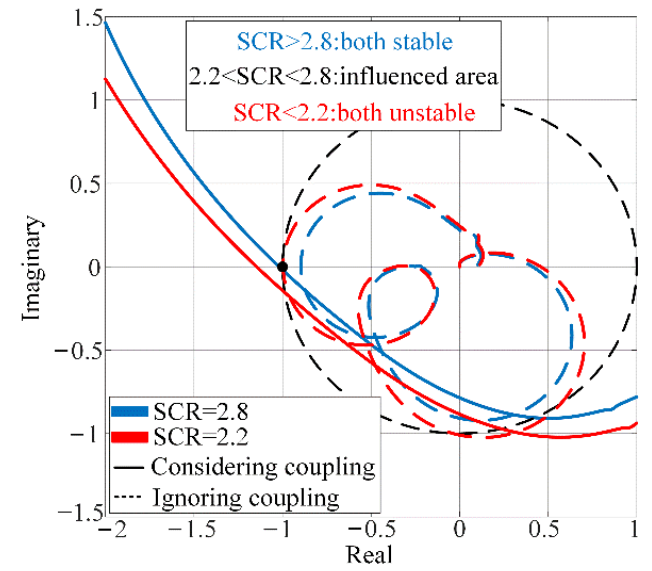
Figure 17. Nyquist plot of the impedance ratios Z g ( s ) Y MMC ( s ) with PLL dynamics. Figure 18 shows the time-domain simulation results of the MMC under a step change of the grid condition, where the PLL bandwidth is set as 40 Hz. It can be seen the system loses stability when SCR = 2.7.